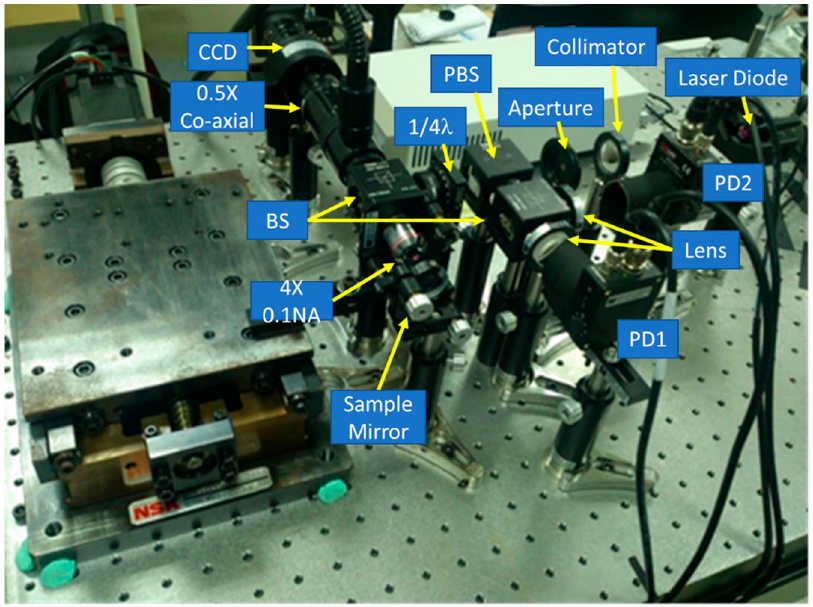
Figure 4. Photograph of the laboratory-built prototype.